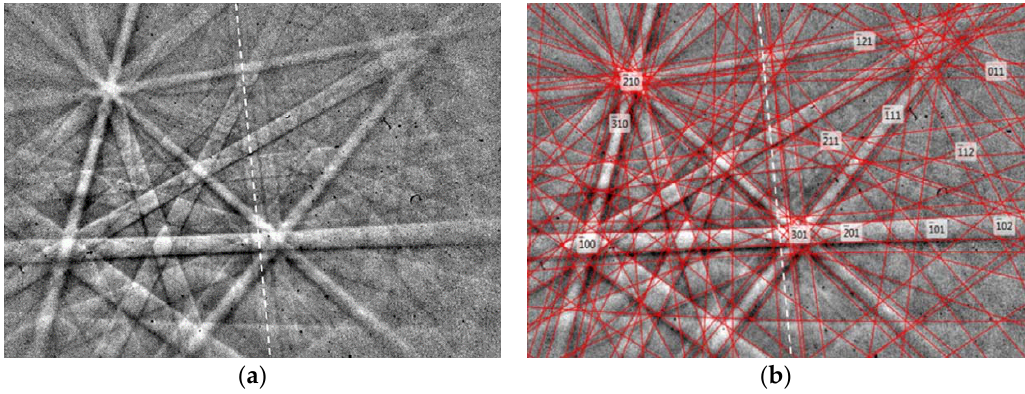
Figure 19. ( a ) Measured and ( b ) simulated electron backscattered diffraction (EBSD) Kikuchi patterns. One of the satellite reflections is highlighted with a white dashed line [142], with copyright permission from © Elsevier .